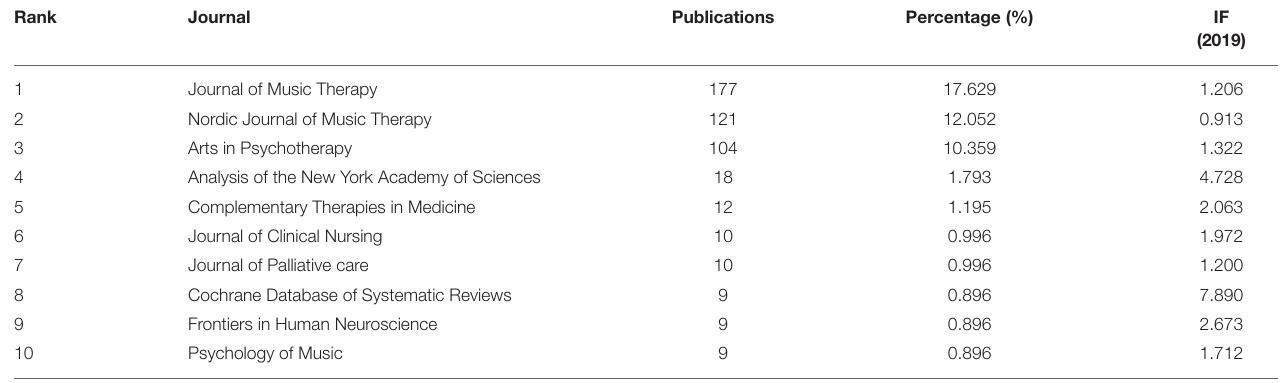
TABLE 3 | Top 10 journals that published articles in the music therapy field.